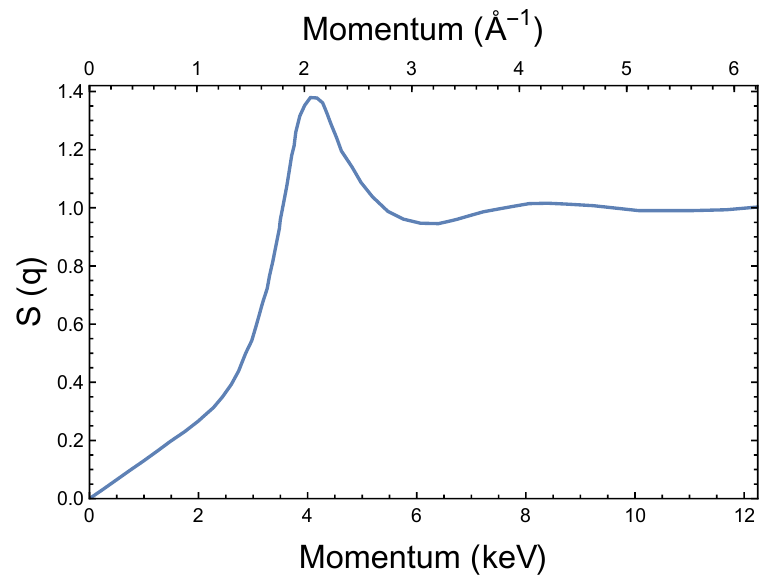
Figure 3 . Interpolation of the data for the static structure function S(q) (at T = 1 K) from neutron scattering experiment